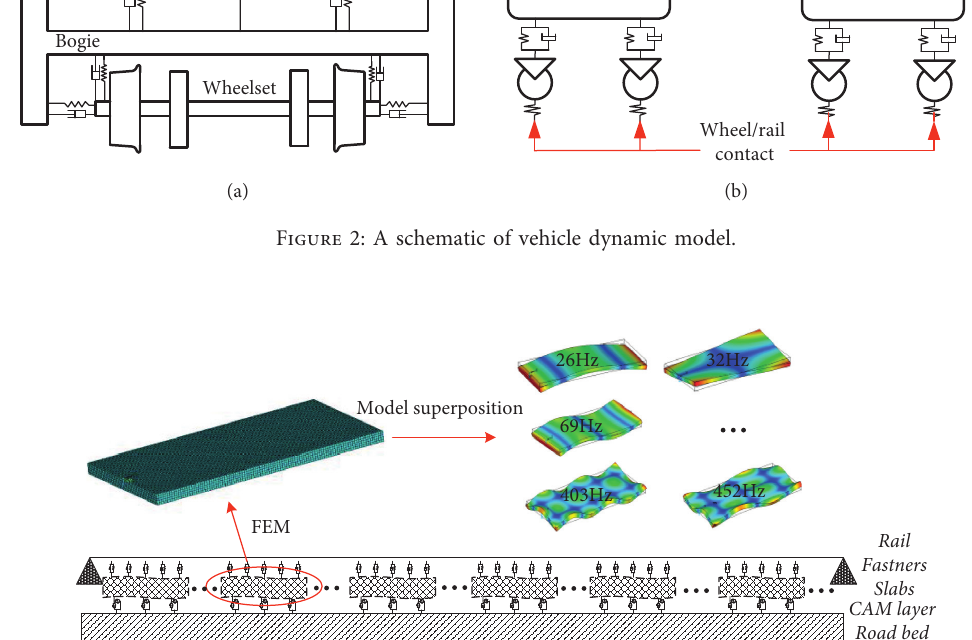
Figure 3: Slab track system used in the high-speed railway